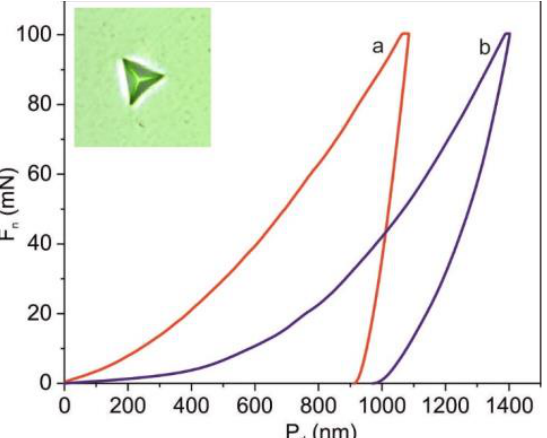
Figure 9. Example of load (F n ) versus indentation penetration depth (P d ) curves for polished ( a ) and cut after CW-CVD process ( b ) Co-Cr discs. The inset shows an imprint obtained for polished sample. Table 2. Mechanical properties as instrumental hardness (HV IT ), instrumental elastic modulus (E IT ), elastic deformation energy (W elast ), plastic deformation energy (W plast ), total deformation en- ergy (W total ), and elastic deformation energy to total energy ratio W elast /W tot (n IT ) for Co-Cr discs.